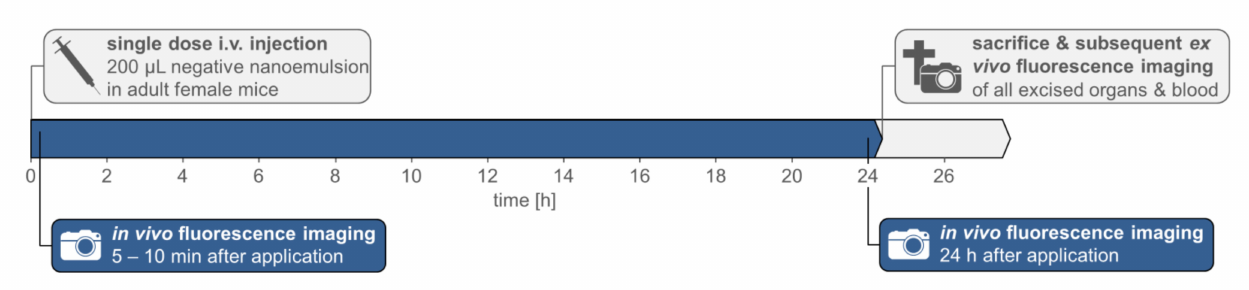
Figure 2. Experimental procedure of the animal